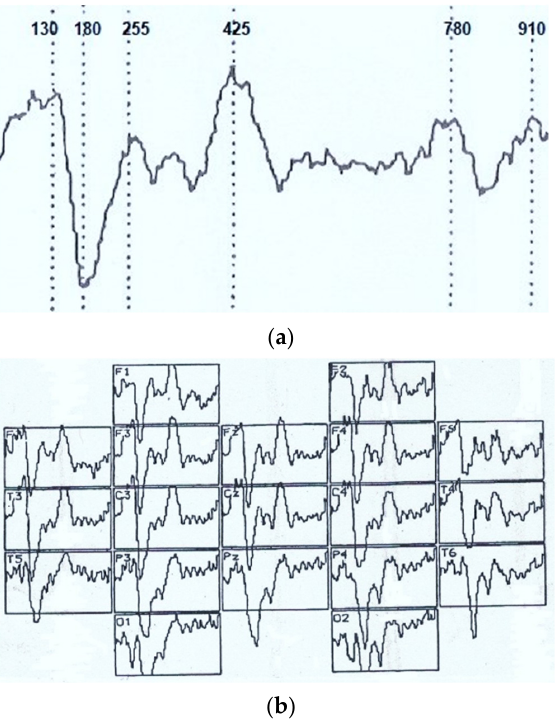
Figure 1. ( a ) The visual evoked potential (numbers—time, ms) and distribution of the VEP ( b ) according to the 10/20 system during the perception of an unrecognizable (oddball) visual image. Analysis time: 1000 ms.